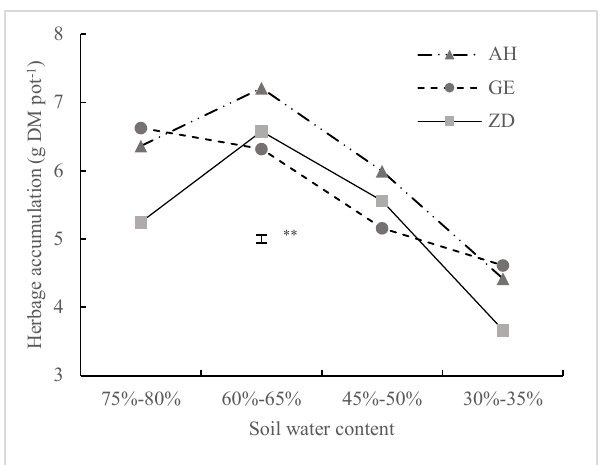
Figure 2. Interaction of soil water content (75 – 80%, 60 – 65%, 45 – 50%, and 30 – 35% water-holding capacity) and cultivars (AH: Aohan; GE: Golden Empress; ZD: Zhaodong) on herbage accumulation of alfalfa. The error bar on the figure represents standard error of the mean, ** p < 0.01.